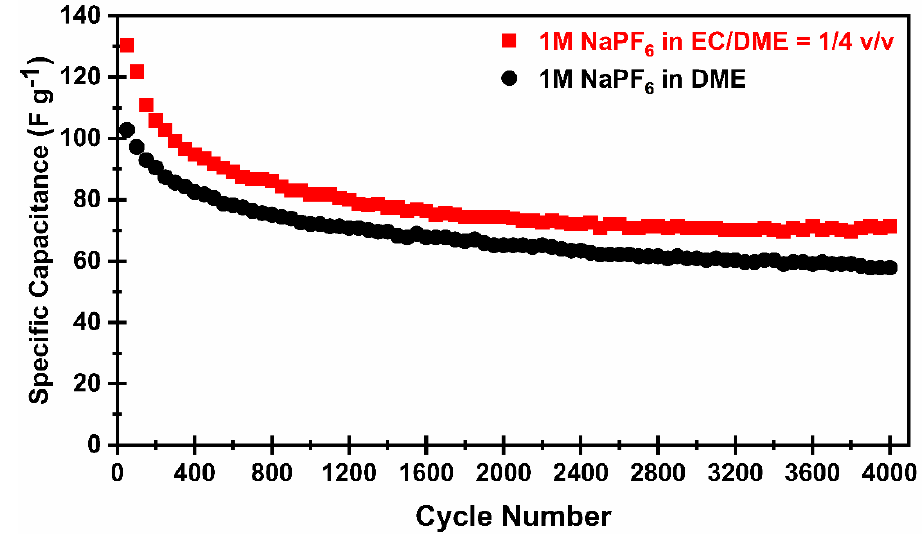
Figure 6. Long-term cycling performance of the KOH activated PC–MF electrode in electrolytes #10 and #11 at a current density of 1.0 A g − 1 and OPV 0–3.25 V.